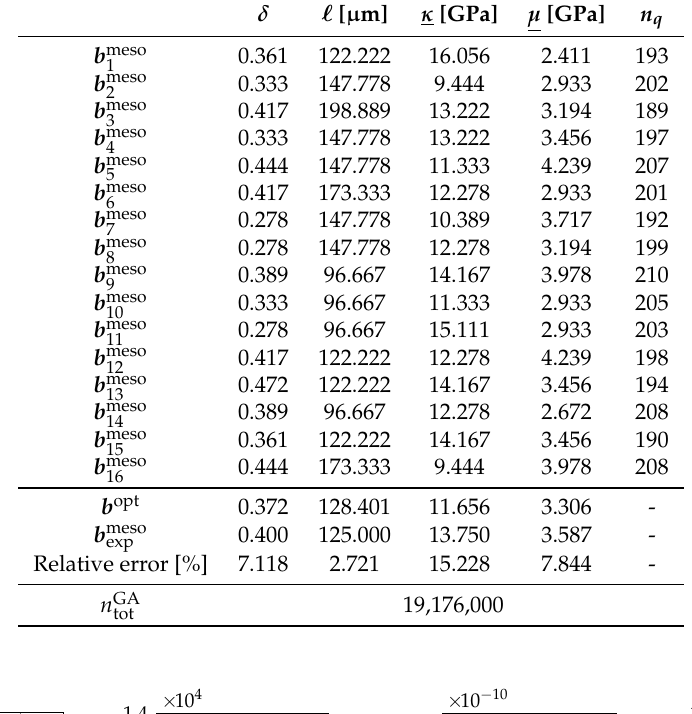
Table 4. Genetic algorithm: comparison between the global optimal value b opt obtained from the Q = 16 identified values b meso , . . . , b meso for each of the Q mesoscopic domains of observation Q 1 Ω meso , . . . , Ω meso , and the reference experimental value b meso exp . exp,1 exp, Q